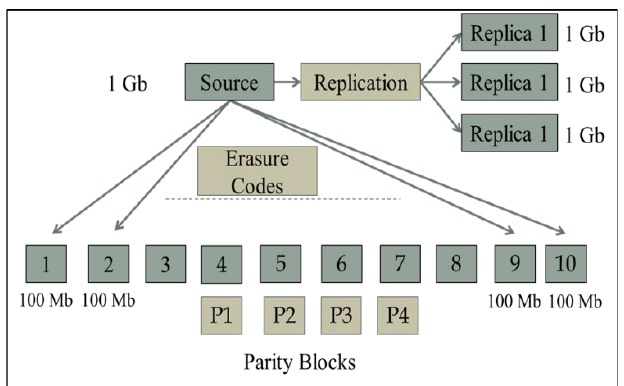
Figure 2. Erasure Code vs